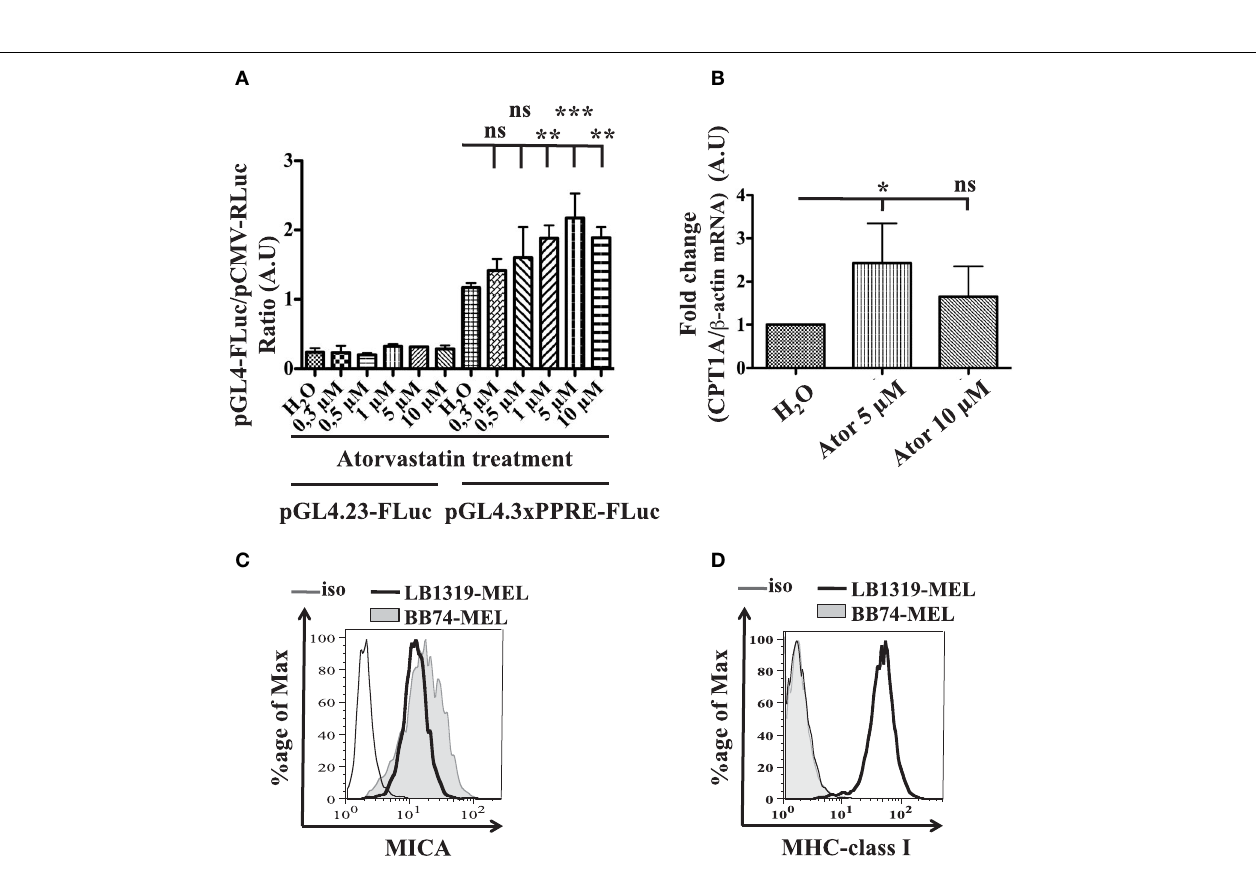
treated with 5 or 10 µ M atorvastatin for 24h or untreated (H 2 O) and CPT1A mRNA relative expression, normalized by β -actin, was detected by RT-qPCR (B) . Results are expressed as mean ± SD (error bars, n = 3 experiments). * P < 0.5; ** P < 0.01; *** P < 0.001 versus control condition using theTukey ANOVA test (A,B) . Expressions of MICA (C) , and MHC class I molecules (D) were compared between LB1319-MEL and BB74-MEL cell lines by flow